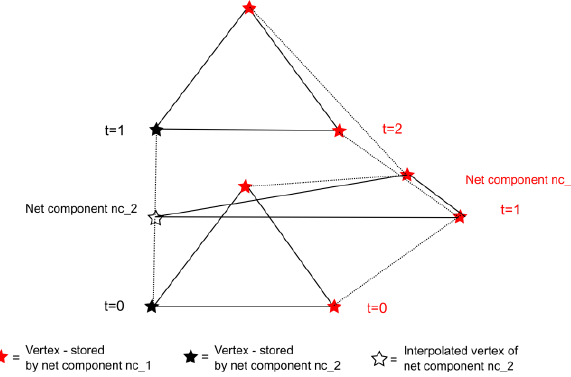
Figure 7. Spatio-temporal prism representing a shared border region with hybrid